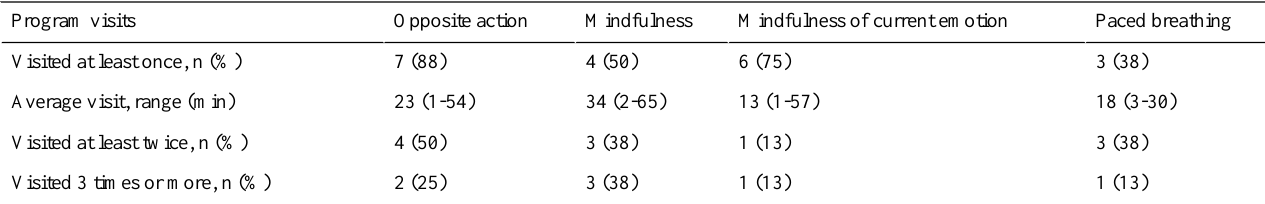
Table 1. Dialectical behavior therapy skill engagement for subsample